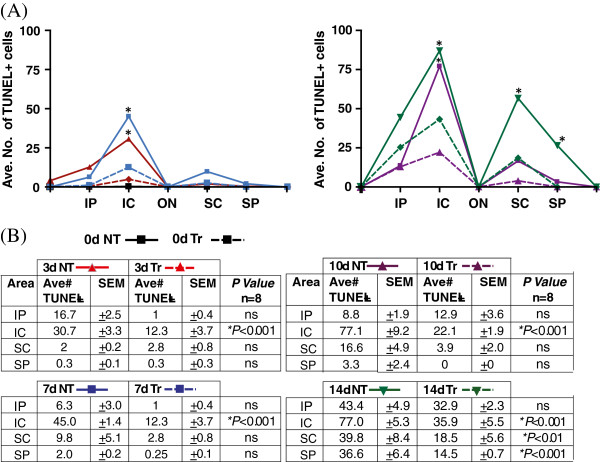
Quantitative analyses of photoreceptors death. (A) TUNEL + photoreceptor cells were counted across the retina (from the inferior to superior) in 0d, 3d, 7d, 10d and 14d animals and data from Nontreated (solid colored lines) and 670 nm Treated (broken colored lines) groups were compared. TUNEL + cells were present in the inferior central area (hotspot) of the nontreated retinas from 3d (solid red line) and the number of cell death increased as a function of hyperoxia-exposure time. (B) In the 14dNT retinas (solid green line), hyperoxia exposure caused widespread cell death that also affected the photoreceptors in the superior retina. By contrast, these numbers were significantly reduced by 670 nm light pretreatment. *Statistically significant difference (p < 0.001) compared to NT groups.